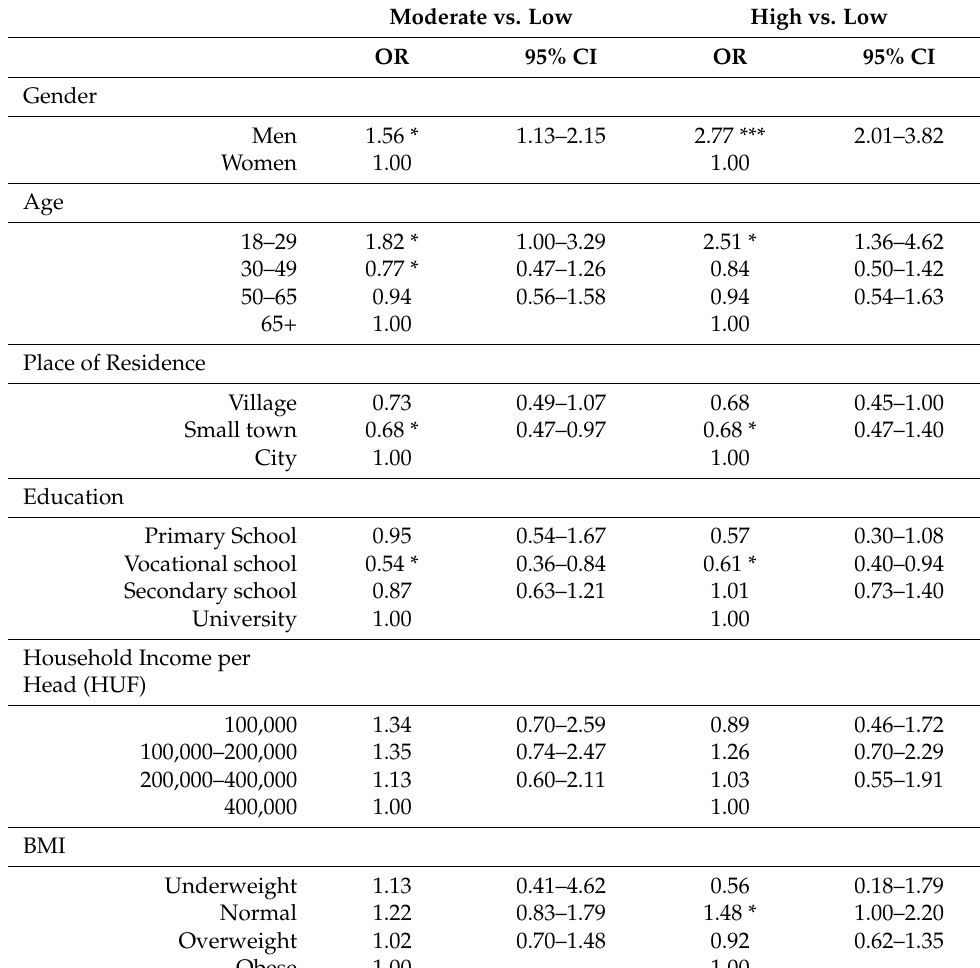
Table 2. Sociodemographic factors associated between low, moderate, and high physical activity. Moderate vs. Low High vs. Low OR